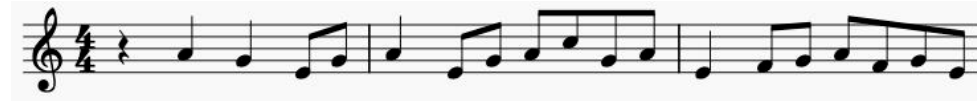
Table 2. Details of autoregressive generation.